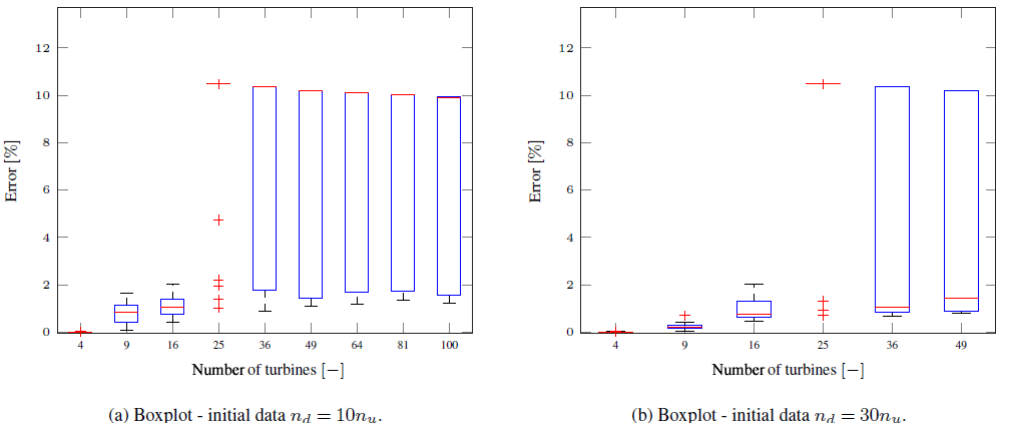
Figure 7. The boxplot of the optimization results for the differently sized wind turbine grids. The red line indicates the median. The bottom and top edges of the blue box indicate the 25th and 75th percentiles, respectively. The red markers indicate outliers, and the whiskers extend to the most extreme data points not considered as outliers. The error in the MA–GP approach and the initial error are dependent on the number of turbines in the row. The difference between both runs is the size of the initial training